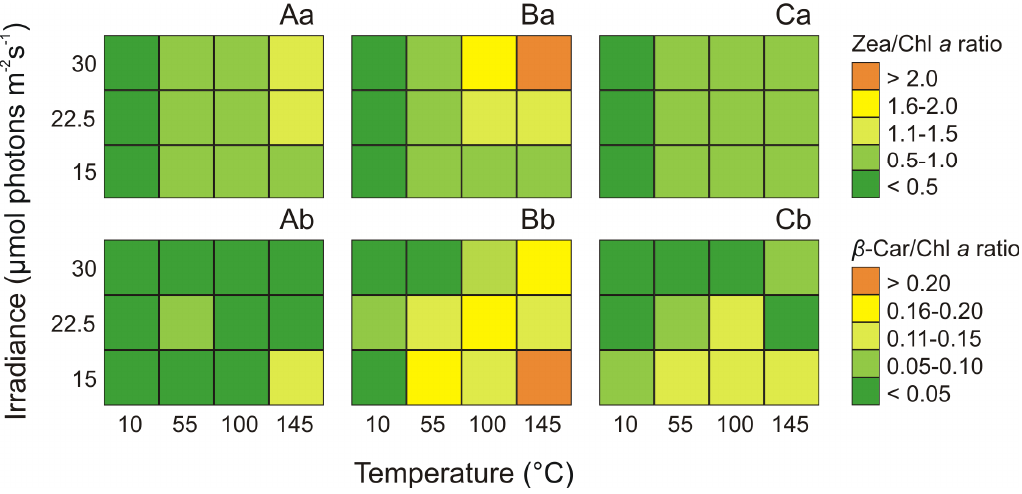
Figure 5. Changes in Zea/Chl a ratio ( a ) and β ‐ Car/Chl a ratio ( b ) obtained after 14 days of experiment for three phenotypes of Synechococcus sp.: Type 1 ( A ), Type 2 ( B ), Type 3a ( C ) under different irradiance ( μ mol photons m − 2 s − 1 ) and temperature (°C)